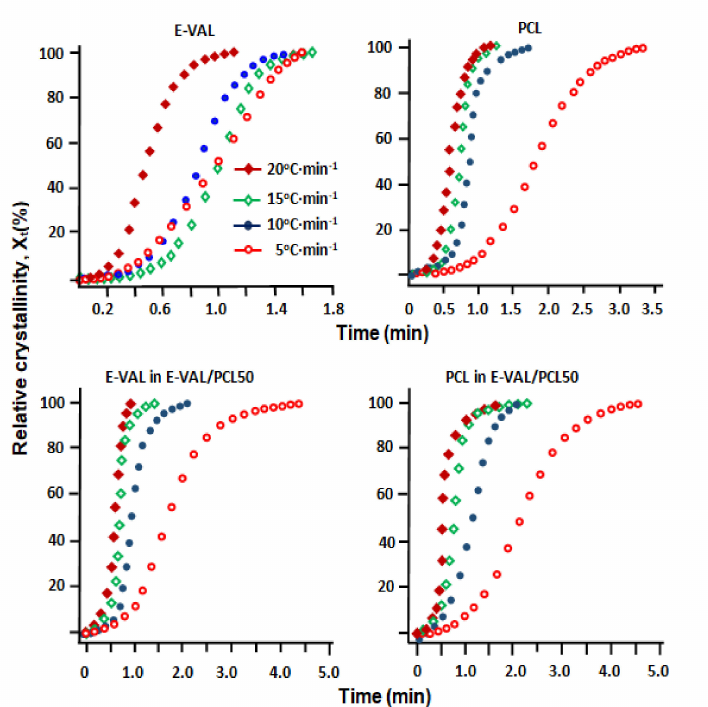
Figure 11. Variation of X T of E-VAL, PCL, E-VAL in E-VAL/PCL50, and PCL in E-VAL/PLC50 with time at different crystallization